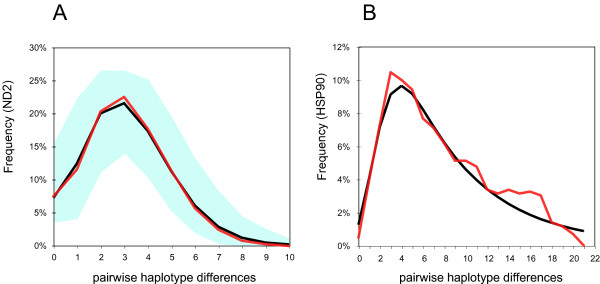
Expansion patterns in mismatch distributions for temperate North American populations of Daphnia rosea. The distribution of pairwise haplotype differences (number of differences) within the major mitochondrial clade (A) and the major nuclear clade (B) of North American populations. Black line indicates the observed distribution. Red line indicates the expected distribution based on the spatial expansion model. Light blue zone indicates the 95% CI range of expected distribution based on the spatial expansion model. The nuclear distribution lacks the 95% CI range, because the least-square fitting algorithm in ARLEQUIN failed to converge.